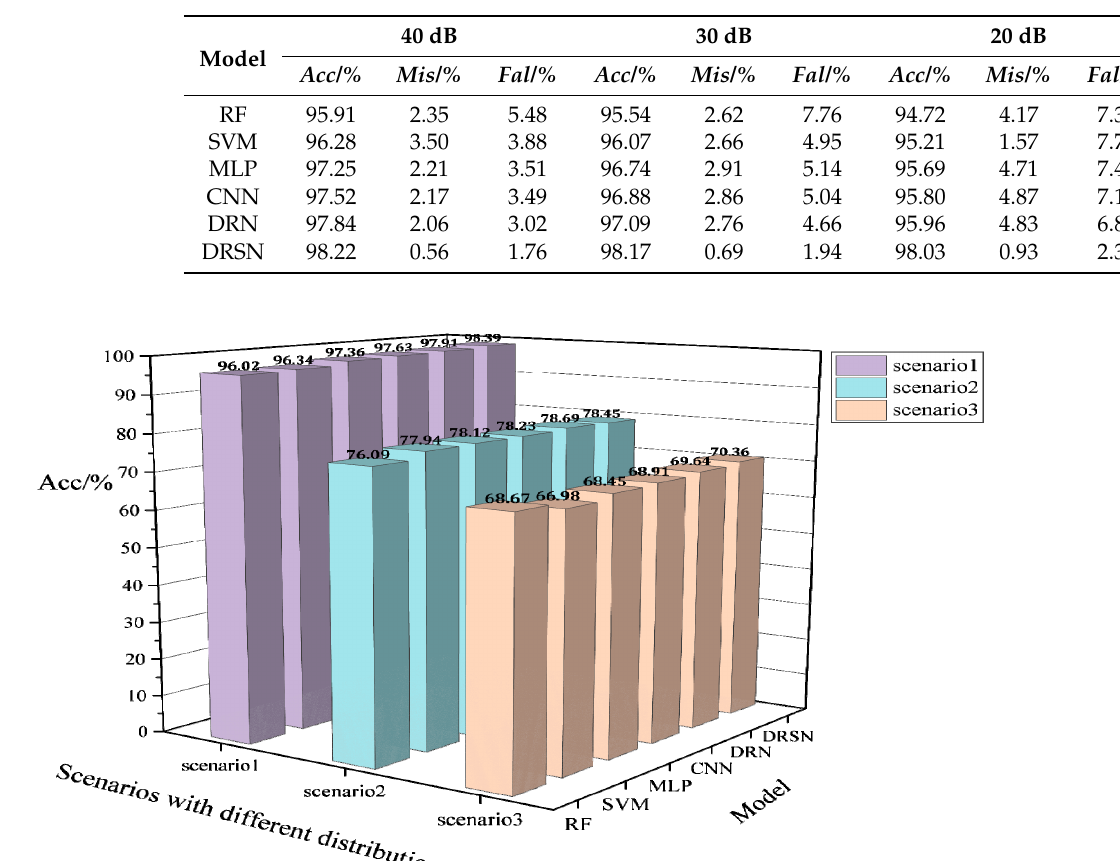
Table 4. Performance of different models on the IEEE 118-bus system with different SNRs.